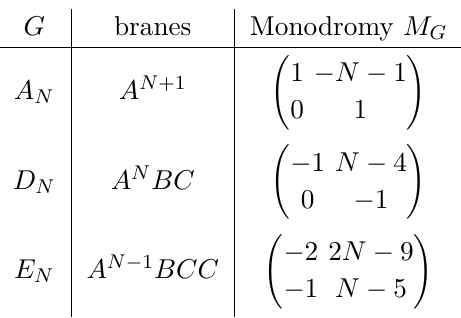
Table 1 . Brane content and monodromies for ADE groups on elliptic K3